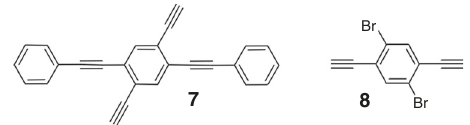
Fig. 7 Similar alkyne molecules used in previous studies. The reaction of 7 leads to the formation of graphdiyne covalent nanowire, while the reaction of 8 gives rise to the formation of binodal organometallic network